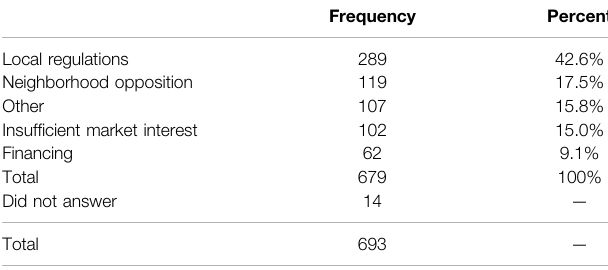
TABLE 4| Frequency ofmost signi fi cantchallenge 2004(Levine and Inam, 2004).